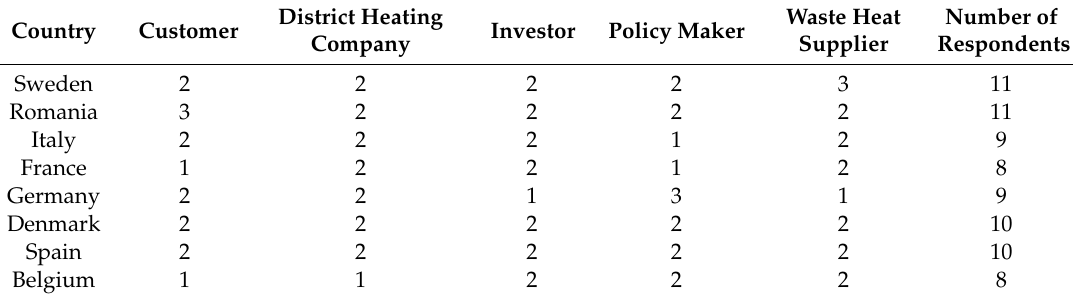
Table 1. The distribution of the